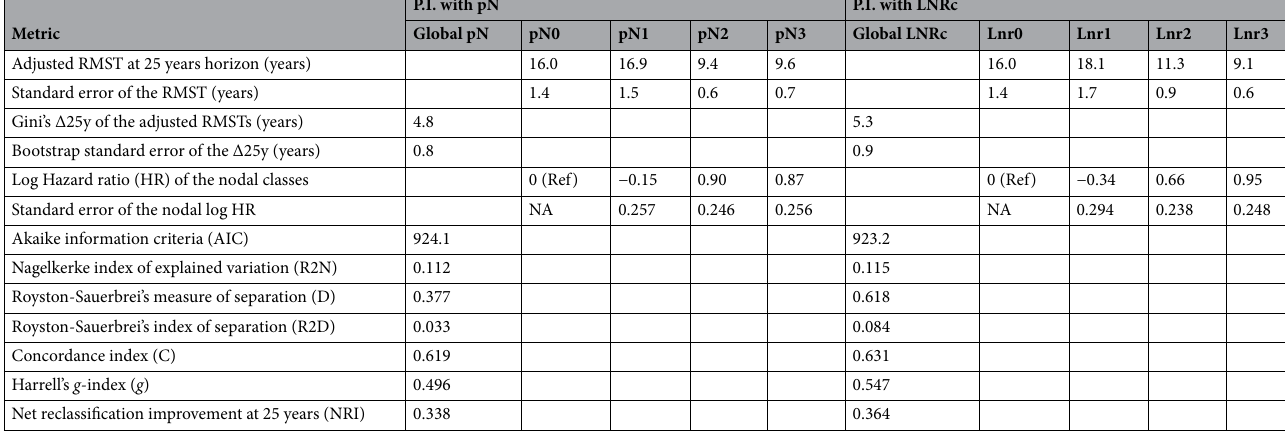
Table 4. Multivariate metrics of the nodal quanta classes. Larger metric value indicates better prognostication, except the Akaike Information Criteria (AIC) for which smaller is better. P.I., prognostic index model as detailed in Table 3. NA not applicable.